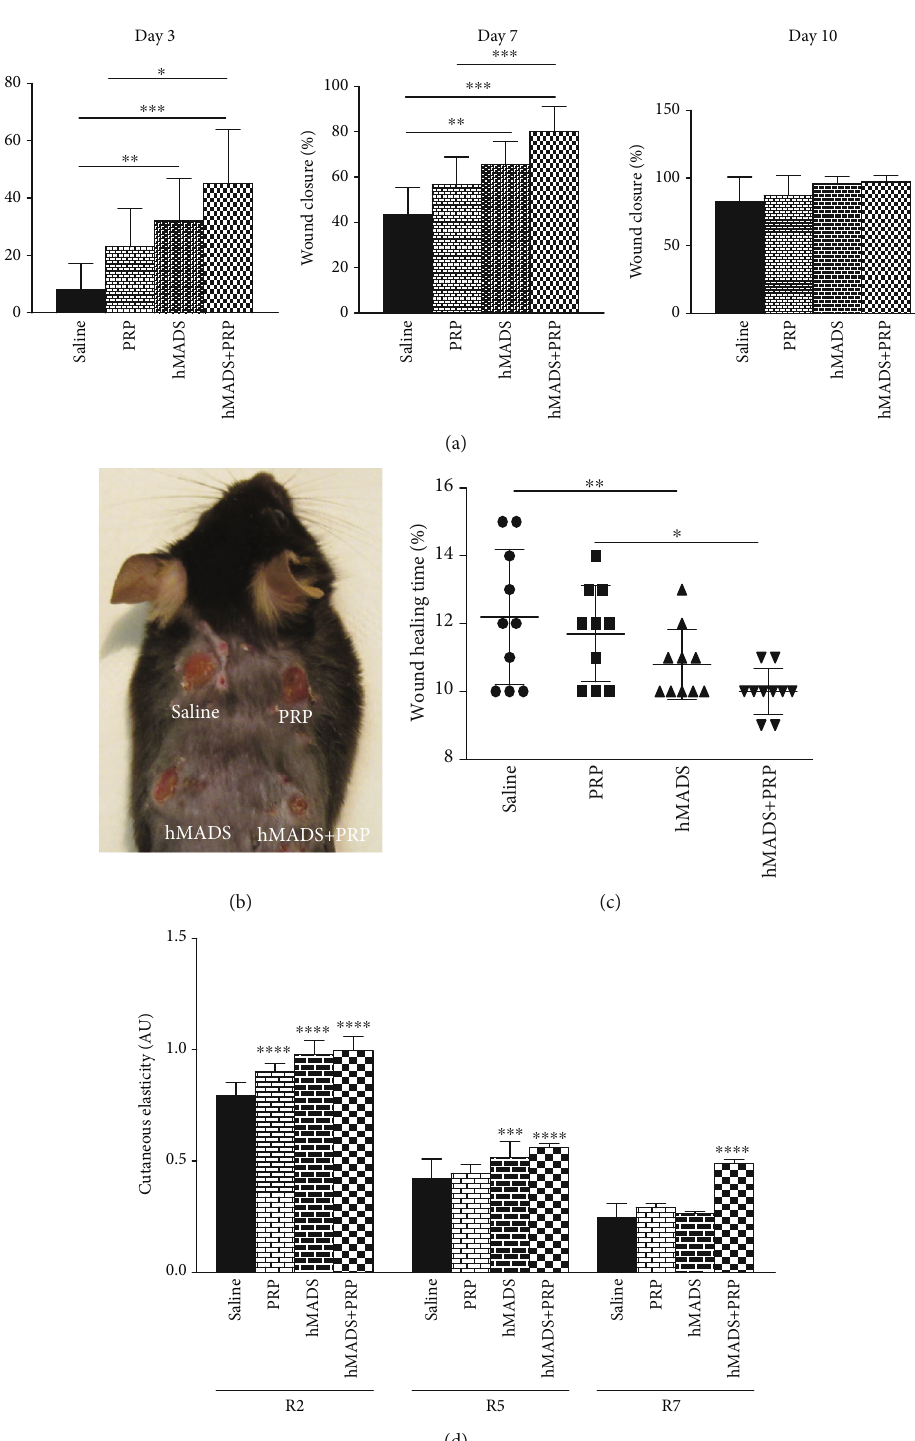
Figure 1: PRP treatment improves the healing potential of human MSC (hMADS cells) following their engraftment into mouse wounds. (a) Closure rates of wounds treated with saline solution, PRP, hMADS cells, or hMADS cells in combination with PRP at day 3, day 7, and day 10 following surgery. (b) Representative photograph of mouse back with skin wounds at day 3 following injury and treatment with either saline solution, PRP, hMADS cells, or hMADS cells in combination with PRP, respectively. (c) Wound healing times from mouse wounds treated with either saline solution, PRP, hMADS cells, or hMADS cells in combination with PRP, respectively. (d) Biomechanical parameters R 2 (gross elasticity), R (net elasticity), R (viscoelasticity ratio), and R (biological elasticity) of the mouse healed wound following their 5 6 7 treatment with either saline solution, PRP, hMADS cells, or hMADS cells in combination with PRP, respectively. (a – d) Results represent the mean ± SD obtained from n = 10 mice. ∗ p < 0 : 05 , ∗∗ p < 0 : 01 , ∗∗∗ p < 0 : 001 , ∗∗∗∗ p < 0 : 0001